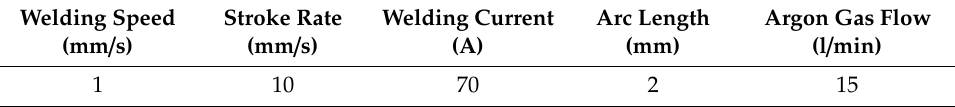
Table 2. Parameters for Varestraint weldability testing using tungsten gas arc welding.